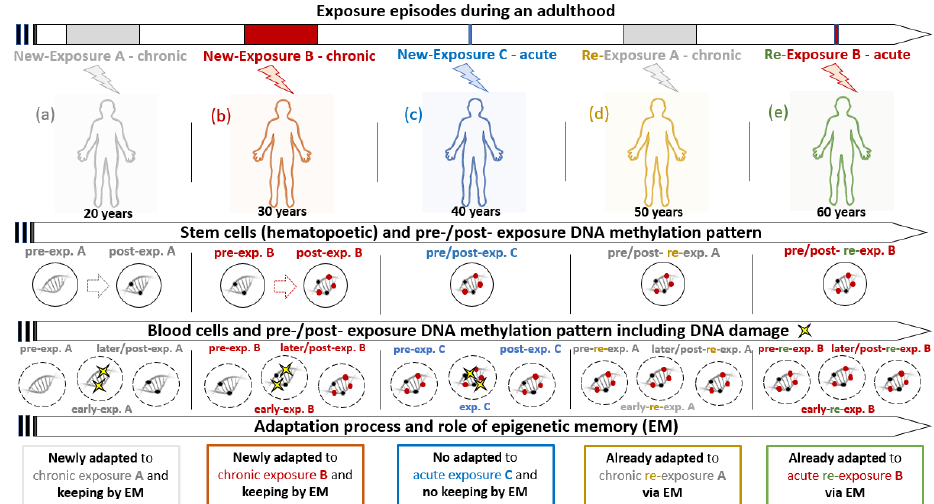
Figure 1. The model of the process of adaptation to environmental exposure and its “storage” by epigenetic memory in stem cells (see Section 4.1.3 for a detailed description of consequences of individual exposure episodes a – e ).